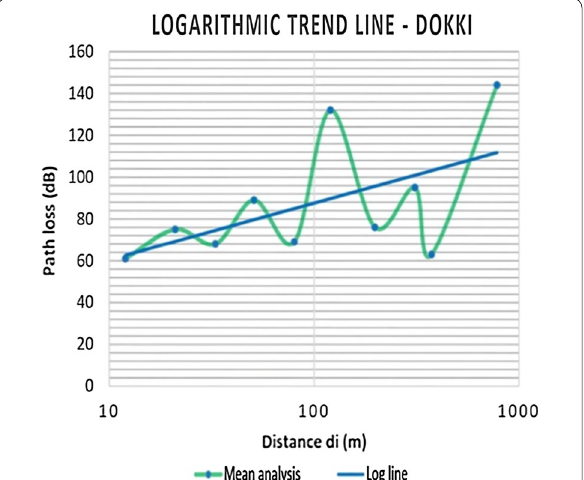
Fig. 8 Regression analysis—logarithmic trend line—Dokki